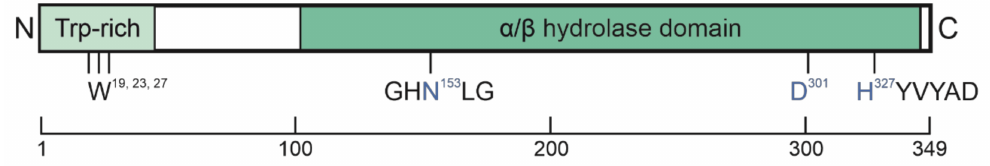
Figure 1. Protein domain organization of human α / β hydrolase domain containing protein 5 (ABHD5). The α / β -hydrolase domain (dark green box), located at the carboxyl terminus of the protein, contains the predicted catalytic triad (indicated in blue) consisting of the consensus GxSxG lipase motif in which the serine is replaced by an asparagine residue (Asn153), and Asp301 as well as His327 within the conserved Hx4D acyltransferase motif. At the amino terminus, ABHD5 harbors a tryptophan (Trp)-rich region (light green box) important for lipid droplet